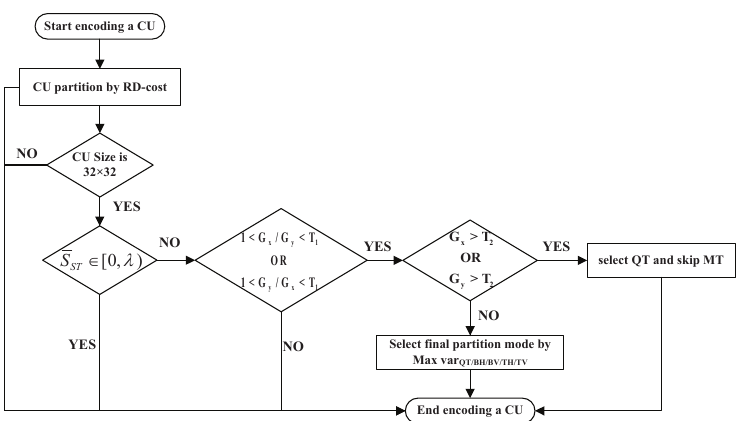
Figure 6. Flowchart of fast CU partitioning